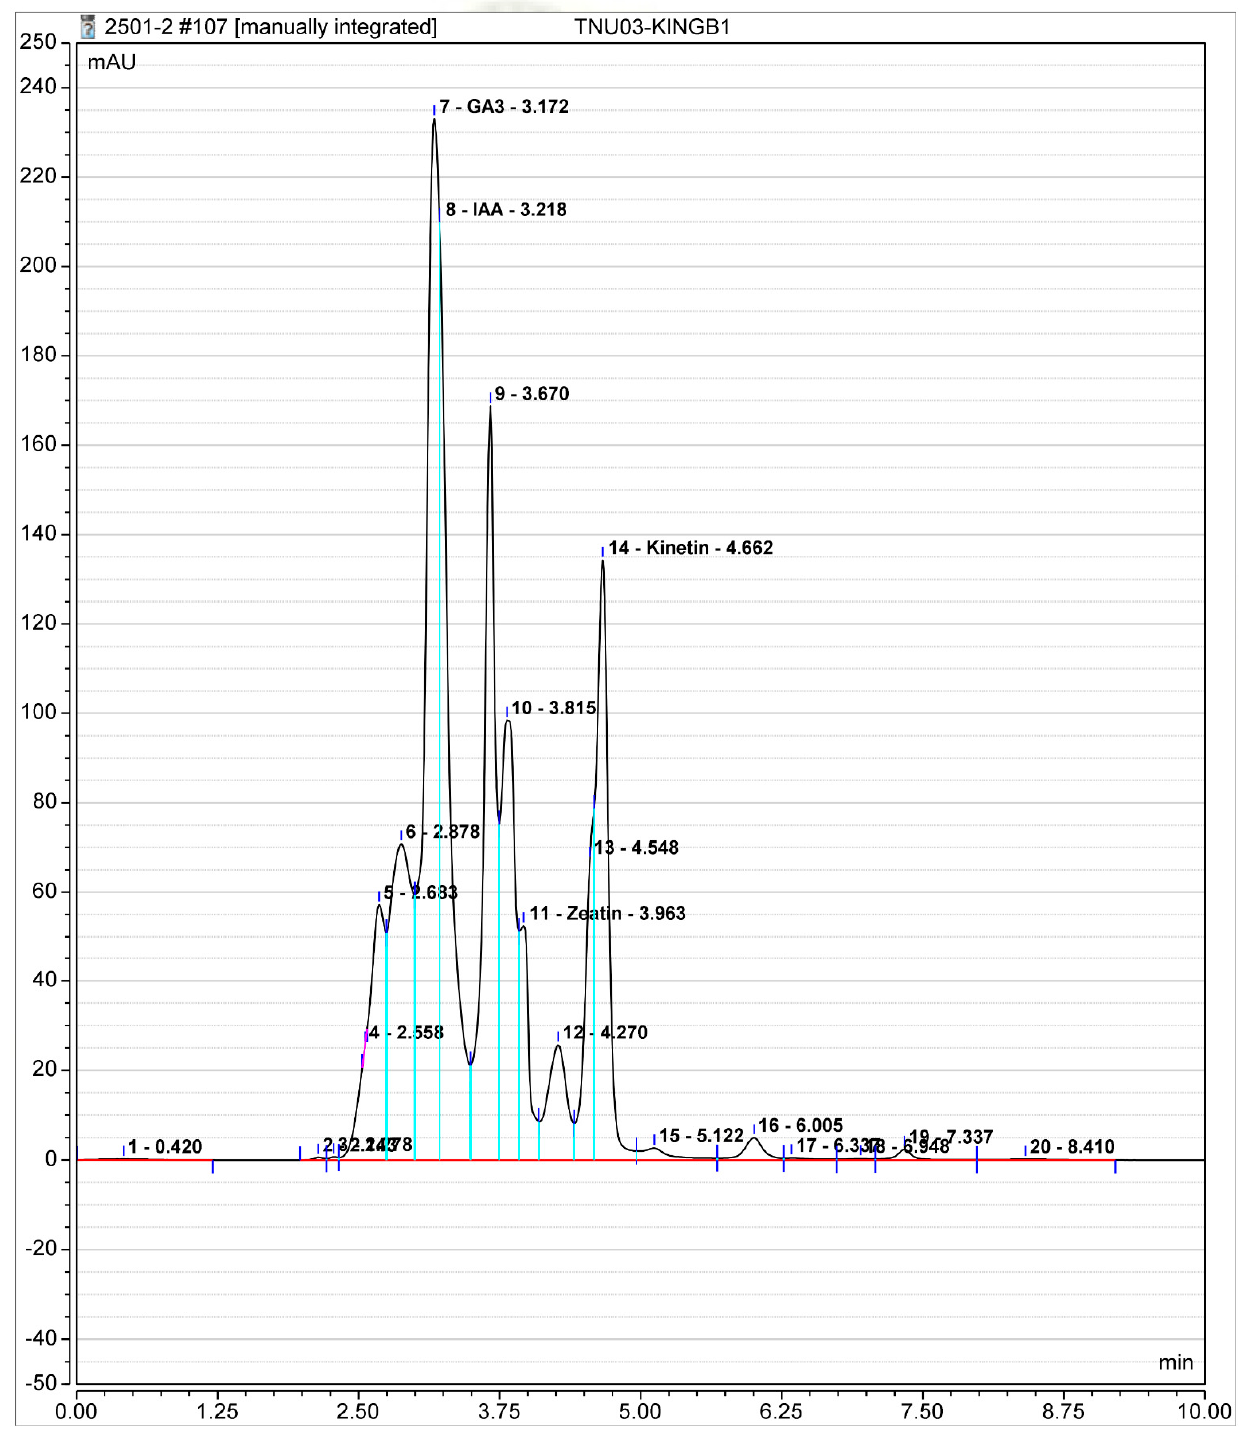
Figure 5. The HPLC profiles of production of plant-promoting compounds (PGPCs) biosynthesized by Pseudomonas aeruginosa TUN03. This bacterial strain was cultivated in King B medium at 28 °C for two days. The fermented culture broth was centrifugated at 8000 rpm for 10 min to remove the residues and bacterial biomass and the supernatant was collected to be used for the detection of PGPCs. Five microliters of culture supernatant were injected into the HPLC system and separated on a C18 column, the PGPCs were detected at the wavelength of 254 nm under the following analysis conditions: mobile phase 60% methanol in water adjusted to pH 5.8 using 10 mM ammonium acetate with a flow rate of 0.8 mL, and a column temperature of 30 °C for 10 min.